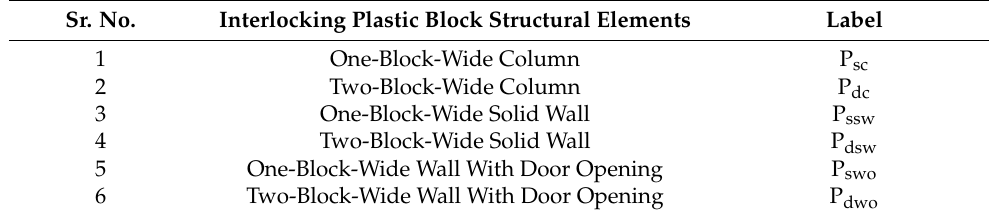
Table 1. Interlocking-plastic-block structural elements’ labels. Sr.